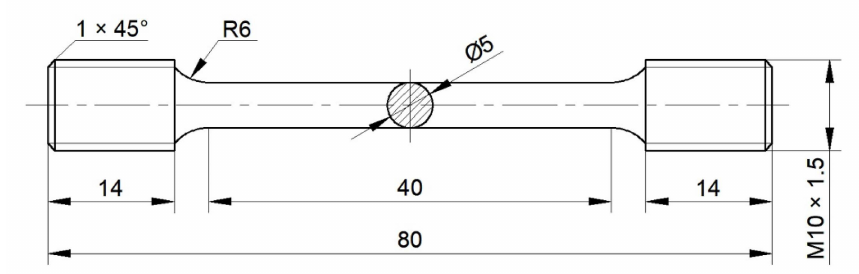
Figure 14. Schematic diagram of tensile